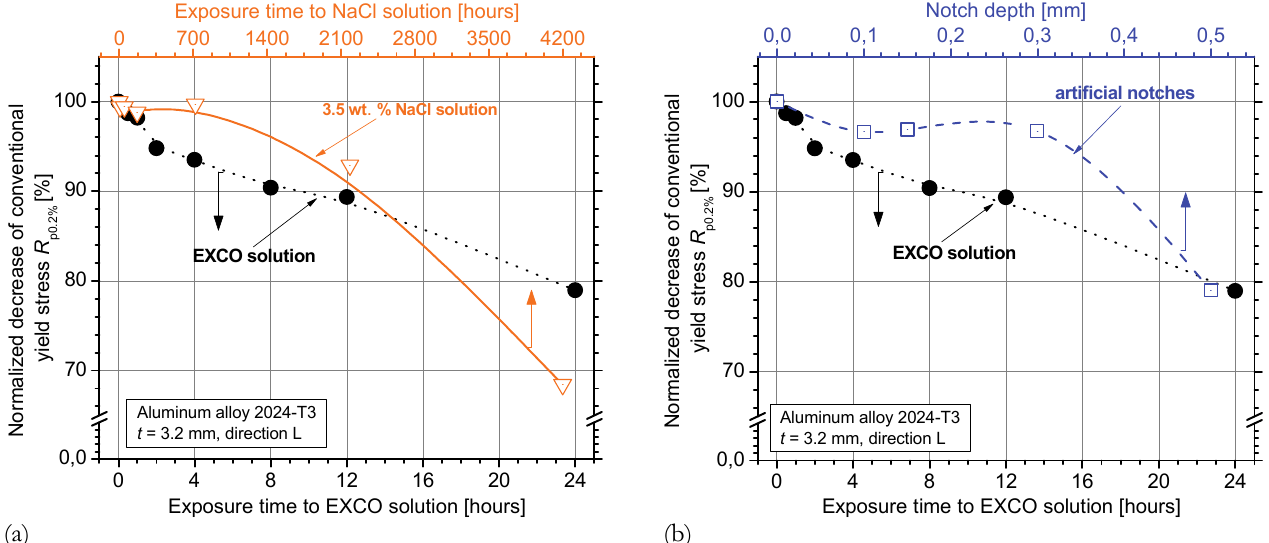
Figure 5: Normalized decrease of conventional yield stress R p0.2% values for the various exposure times of AA2024-T3 to the EXCO solution compared with (a) 3.5 wt. % NaCl solution and (b) notch